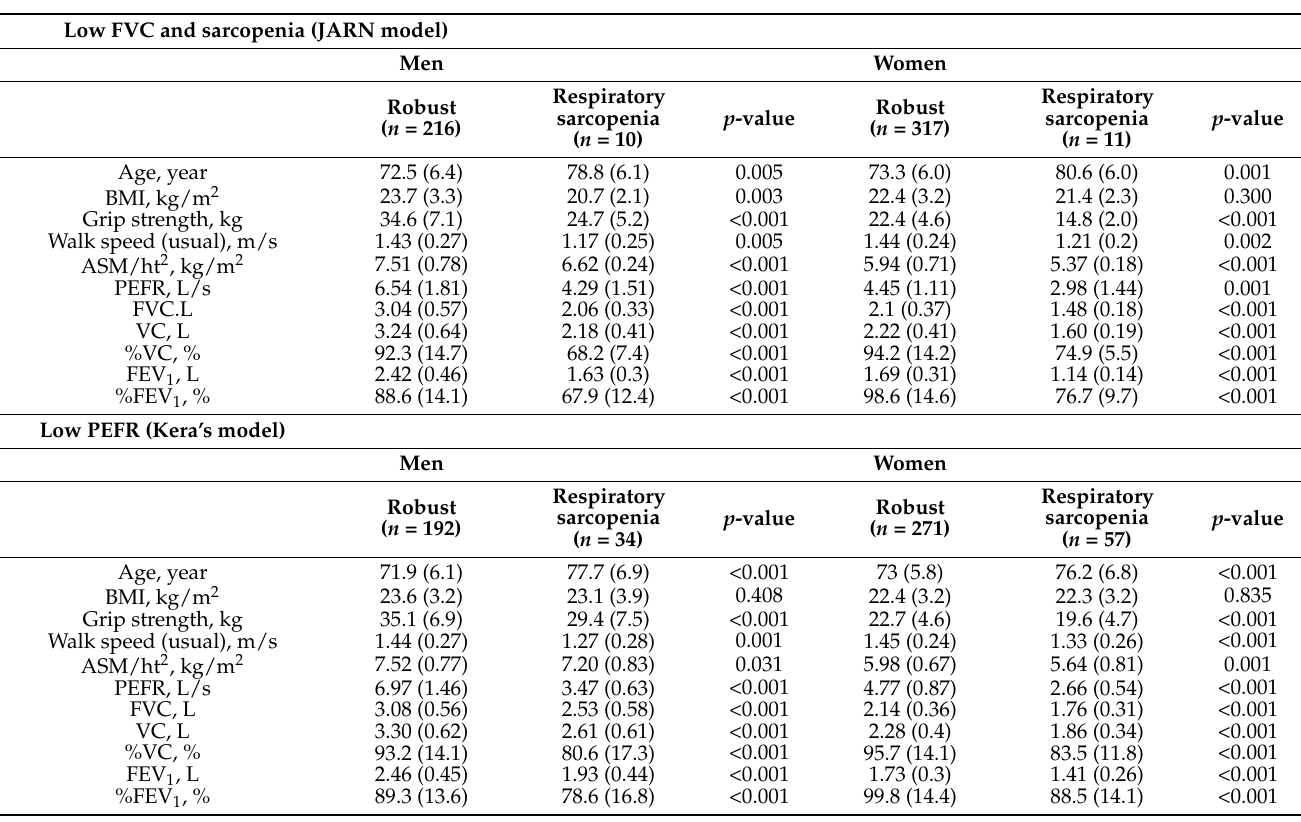
Table 1. Characteristics of respiratory sarcopenia between JARN and Kera models by sex. Low FVC and sarcopenia (JARN